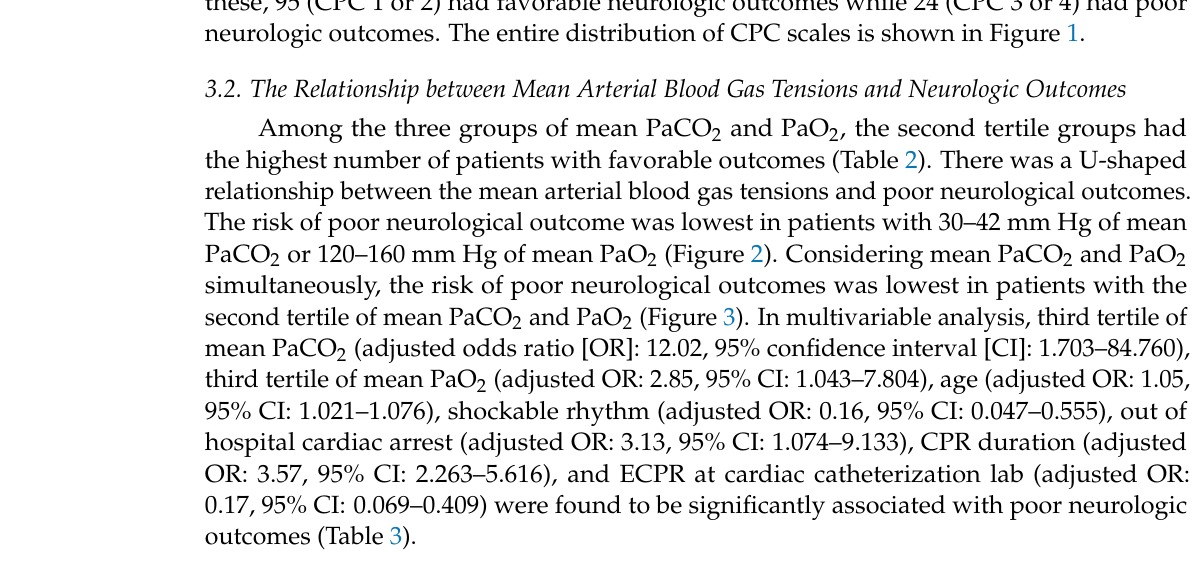
Table 2. Comparison of mean blood gas tension distribution between the favorable neurological outcome group and poor neurological outcome